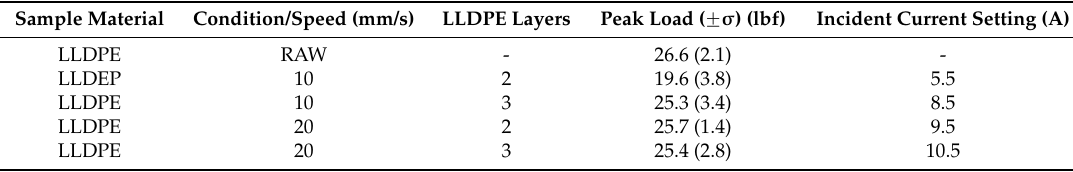
Figure 14. Typical load-elongation curves for sample conditions described in Table 3. Samples were subjected to a cross-head displacement of 1 in/min. Table 3. Maximum sustained peak load above shear point of LLDPE